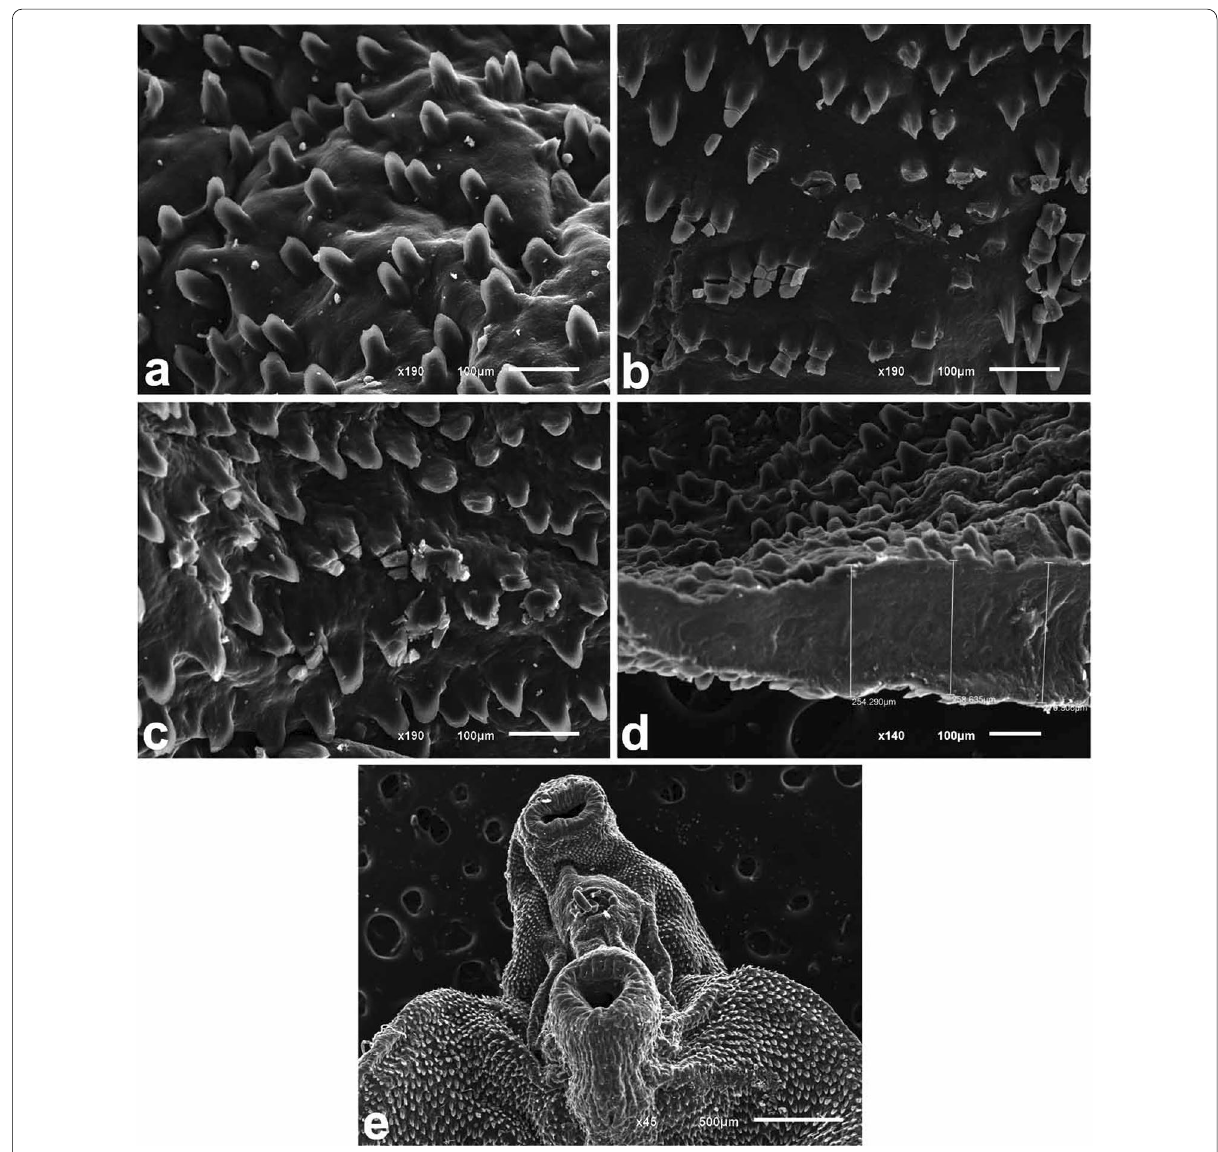
d Ventral tegumental surface. b , c Middle and tail tegumental surface showing moderate furrowing, and destruction in the spines. e Ventral